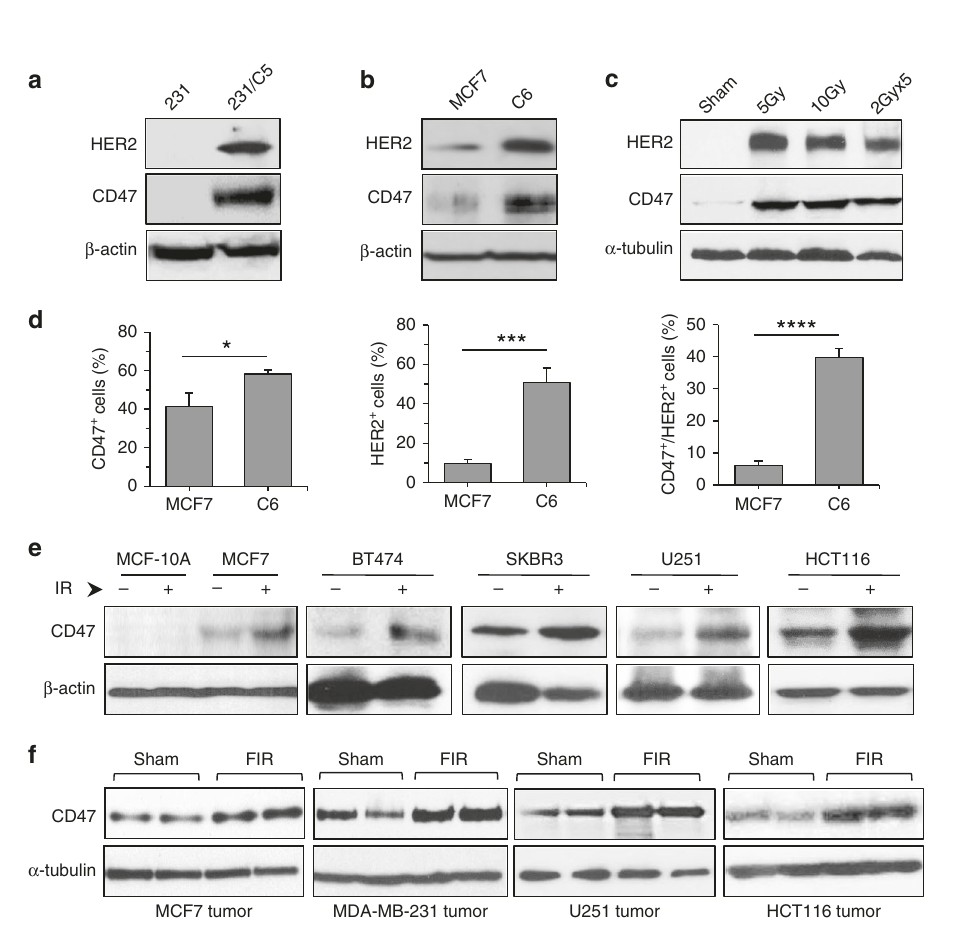
Fig. 1 Expression of CD47 is linked with HER2 status. a Co-expression of CD47 and HER2 across multiple human cancers (red) compared to corresponding normal tissues (blue) obtained from GEPIA database; expression of CD47 and HER2 in 1085 BC patients and 291 normal tissues are shown in the right. T tumors, N normal tissues. * P < 0.05. b Expression of CD47 preferring in HER2-expressing BC cells (MCF7, MCF7/C6, SKBR3, and BT474) compared to HER2-negative MDA-MB-231 and BT549 cells. c Immunoblotting of HER2 and CD47 in tumors from diagnosed HER2 + and HER2 − BC patients. d Left, representative images scored as low, moderate, and high CD47 staining. Right, numbers of patients with low, medium, or high IHC staining of CD47 grouped by HER2 positive or negative status (total HER2 + tumors n = 18; total HER2 − tumors n = 18). e Left, representative IHC of CD47 and HER2 in paired primary and recurrent samples from the same patients. Right, numbers of patients with low, medium, or high IHC staining of CD47 grouped by primary or recurrent status (total primary tumors n = 18; total recurrent tumors n = 18). f Probability of recurrence-free (RFS) and g distant metastasis- free survival (DMFS) of BC patients of all subtypes strati fi ed according to HER2 CD47 signature expression within HER2 strata from Breast Cancer Meta- base: 10 cohorts 22k genes database generated by SurvExpress (http://bioinformatica.mty.itesm.mx:8080/Biomatec/SurvivaX.jsp) from the HER2 probe 210930_s_at combined CD47 probe 211075_s_at. Statistical signi fi cance was analyzed by log-rank test.